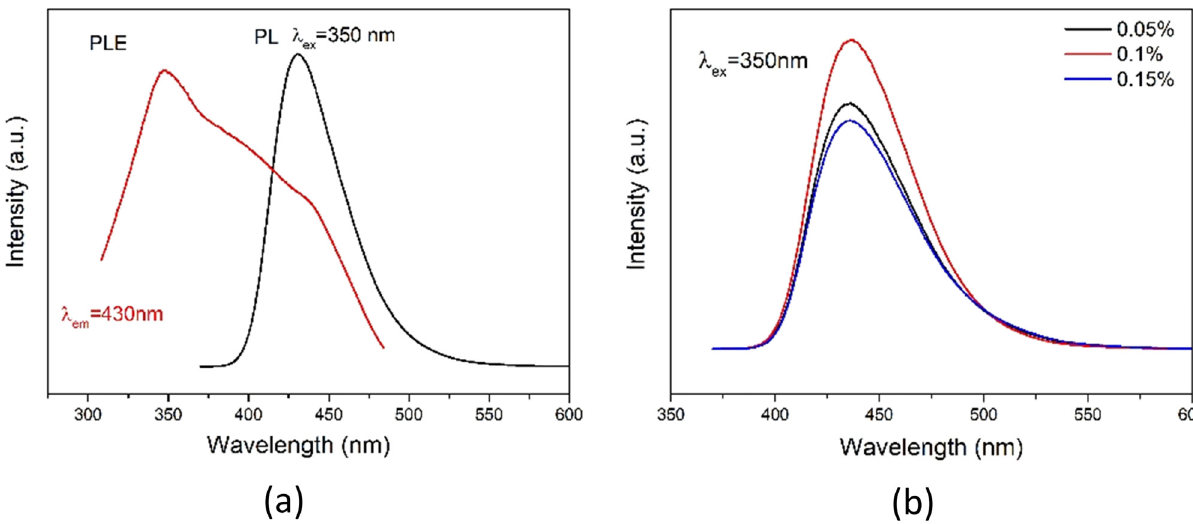
Figure 5: ( a ) PLE and PL spectra of KBP:0.1% Eu 2 + sample and ( b ) photoluminescence emission spectra of KBP: x Eu 2 + ( x = 0.05 – 0.15% ) phosphors ( λ em = 430 nm, λ ex = 350 nm ) .